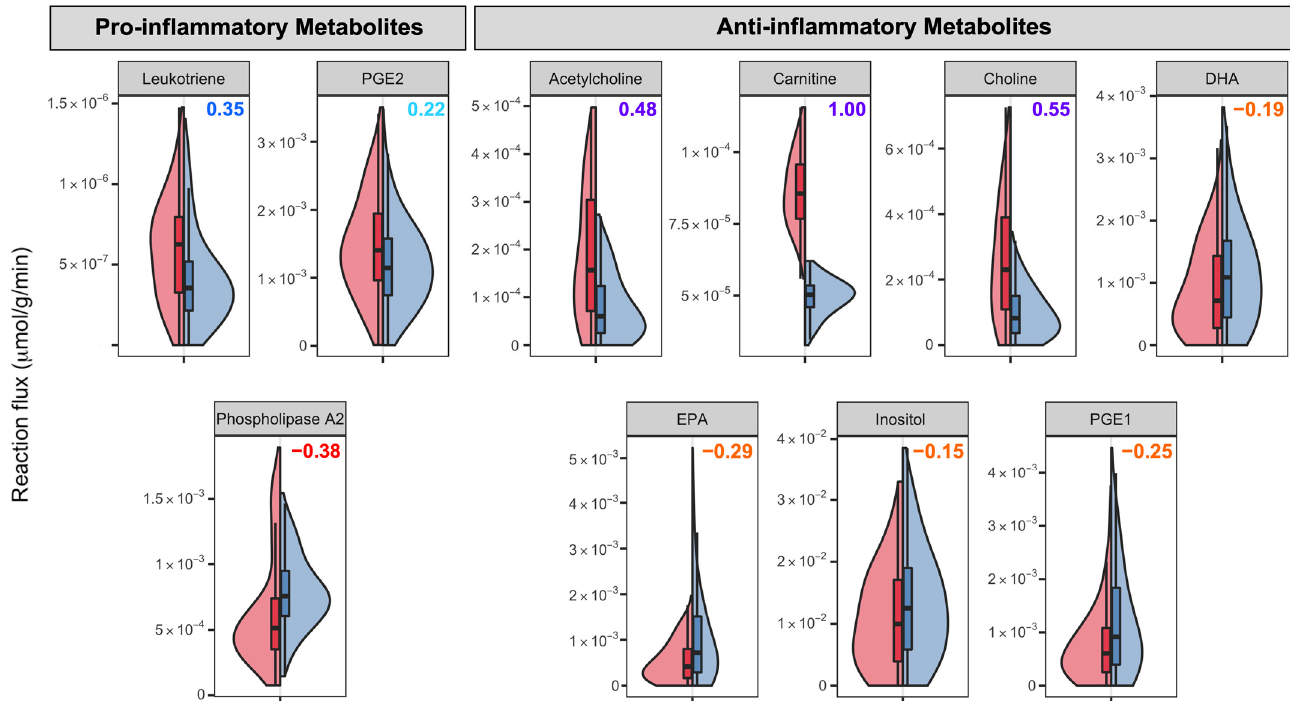
Figure 6. Reaction fluxes for several inflammatory markers in µmol/(g min) acquired by uniform sampling of the ASD-specific and control models. The numbers in the upper right corner of each graph denote the Cliff’s d values. The color codes for Cliff’s d values can be seen in Figure 5. DHA: Docosahexaenoic acid, ENA: Eicosapentaenoic acid, PGE1: Prostaglandin E1, PGE2: Prostaglandin E2.